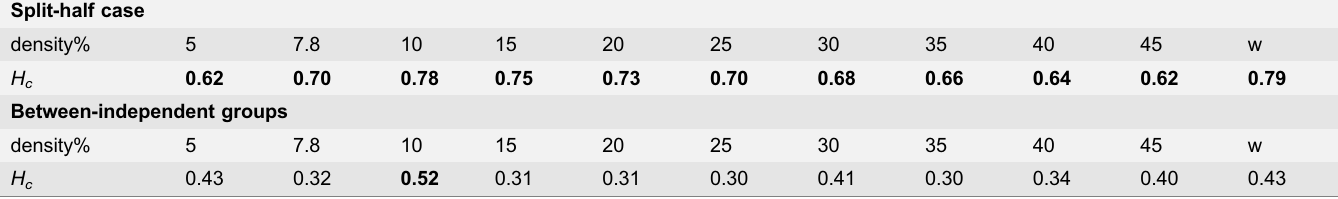
Table 5. Co-occurrence of hubs H C .